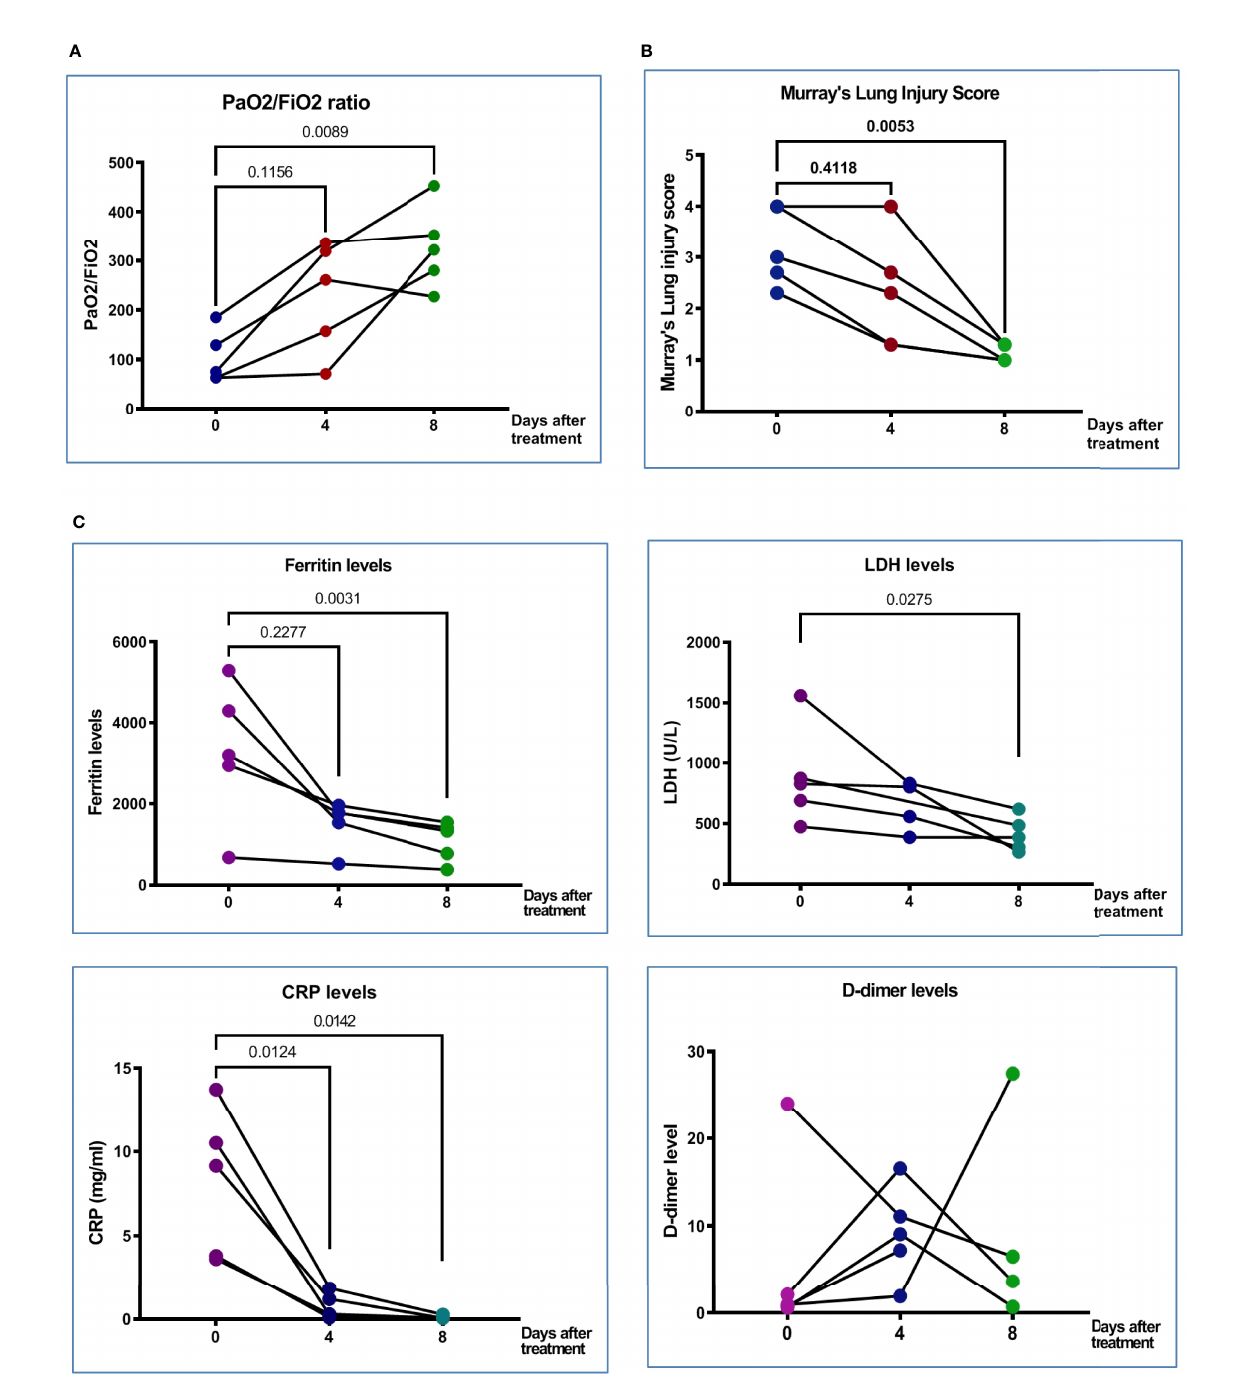
FIGURE 1 | Clinical characteristics and clinical outcomes of patient with COVID-19. (A) PaO 2 /FiO 2 ratio at Day 0 (before treatment), Day 4 (after the fi rst treatment with MSC), and Day 8 (after second treatment with MSC) in fi ve treated patients. (B) Murray ’ s lung injury score was shown before and after treatment; timing of after was adjusted as one week after recruitment. (C) Serum proin fl ammatory markers, derritin, LDH, CRP, and D-dimer on Days 0, 4, and 8 after pcMSCs therapy of fi ve treated patients. The P value was as indicated. Nonparametric Wilcoxon sign-rank